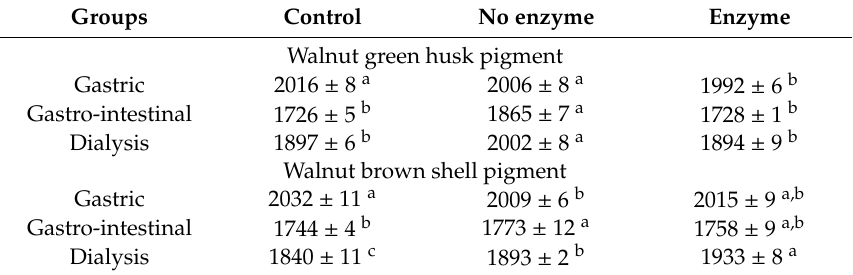
Table 5. The · OH scavenging activity of walnut green husk and brown shell pigment subjected to simulated in vitro digestion and dialysis ( µ mol TE / L).